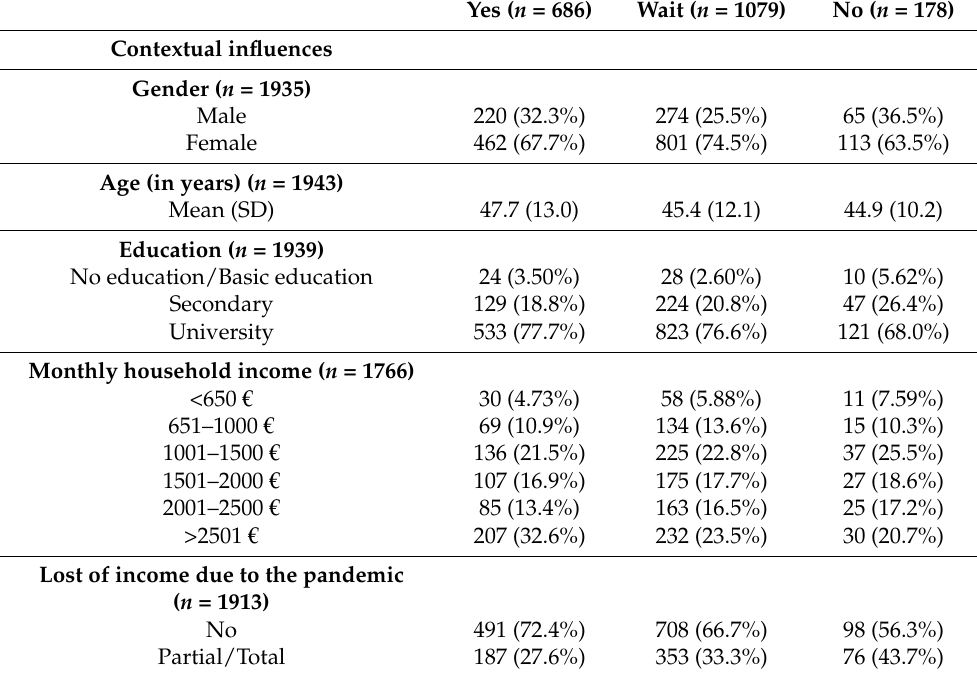
Table 2. Sample characteristics according to contextual, individual and group, and COVID-19